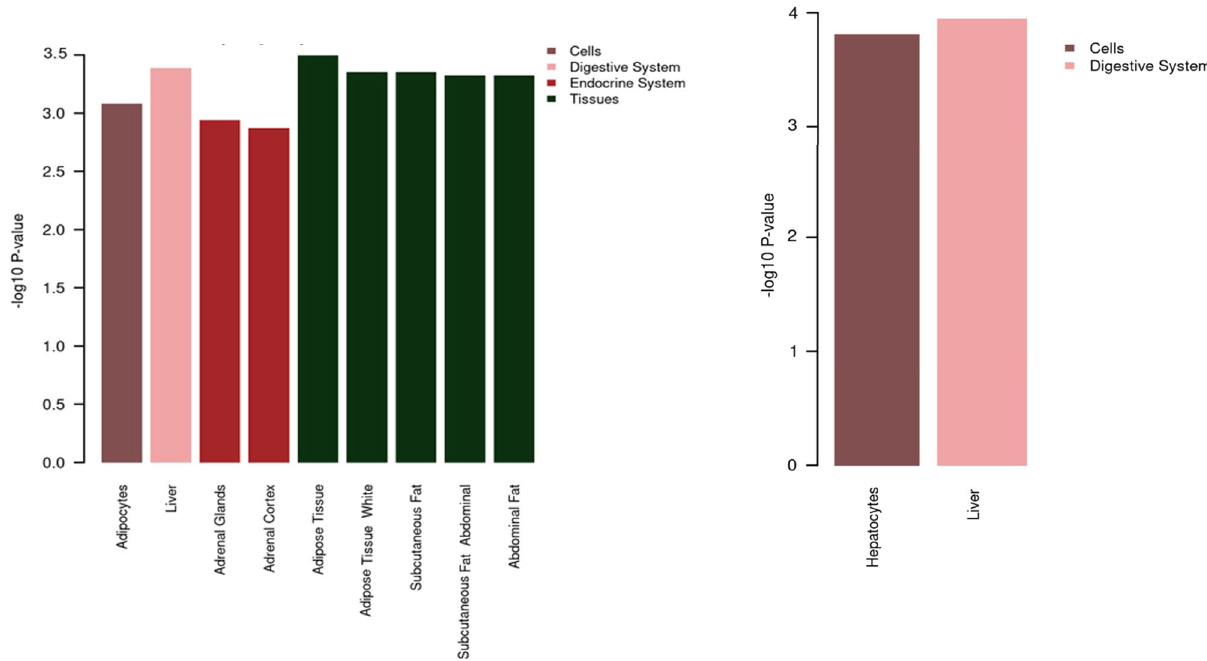
Fig. 6 Overview of tissue and physiological systems enrichment using DEPICT. Illustrated are the tissues and organs enriched with genes mapped to ALT ( a ) and ALP ( b ) SNPs. False discovery rate <0.05 was used to identify enriched